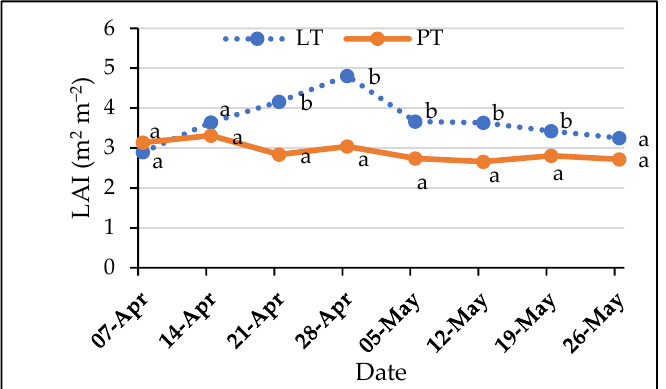
Figure 6. Leaf area index in the two treatments from 7 April 7 to 26 May. Within each date, the same letters are not significantly different at p < 0.05 by Tukey’s multiple comparison test.